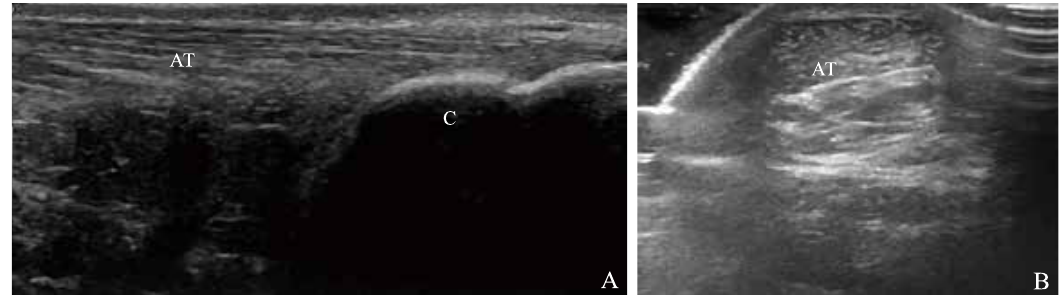
Figure 1 Normal Achilles tendon. Longitudinal (A) and transverse (B) ultrasound scans of a normal AT. AT, Achilles tendon; C,